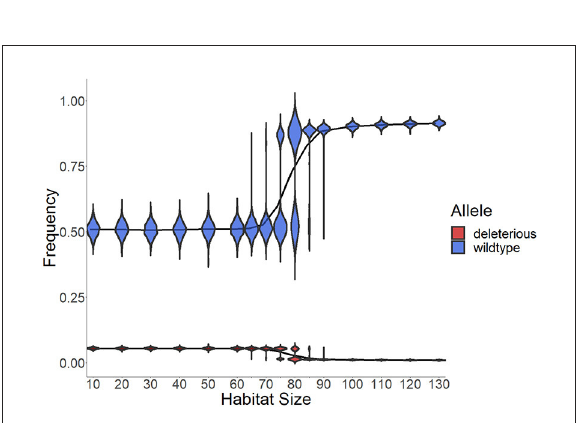
FIGURE4 Frequency of wildtype and deleterious alleles at the end of the simulation. All 9 types of deleterious alleles (red) are summarized to average frequency of each mutation, therefore showing the frequency one individual mutation will have. The line should help understand the probability that a partner an individual met carries the same mutation as itself. Lines show the average frequencies of all (1,000) replicates over the entire simulation time. Violin areas indicate the distribution of allele frequencies among replicates. At low densities (large habitat size g ), the frequency of wildtype alleles (blue) is high. This is because at low density selfing happens more frequently, and deleterious alleles are purged. Data from the same simulation shown in Figure 3, therefore using default parameters as shown in Table 1, and various habitat sizes g , with 1,000 replicates. The frequencies of the underlying genotypes are shown in Supplementary Figure 7, and the changes in wildtype frequency over time in Supplementary Figure